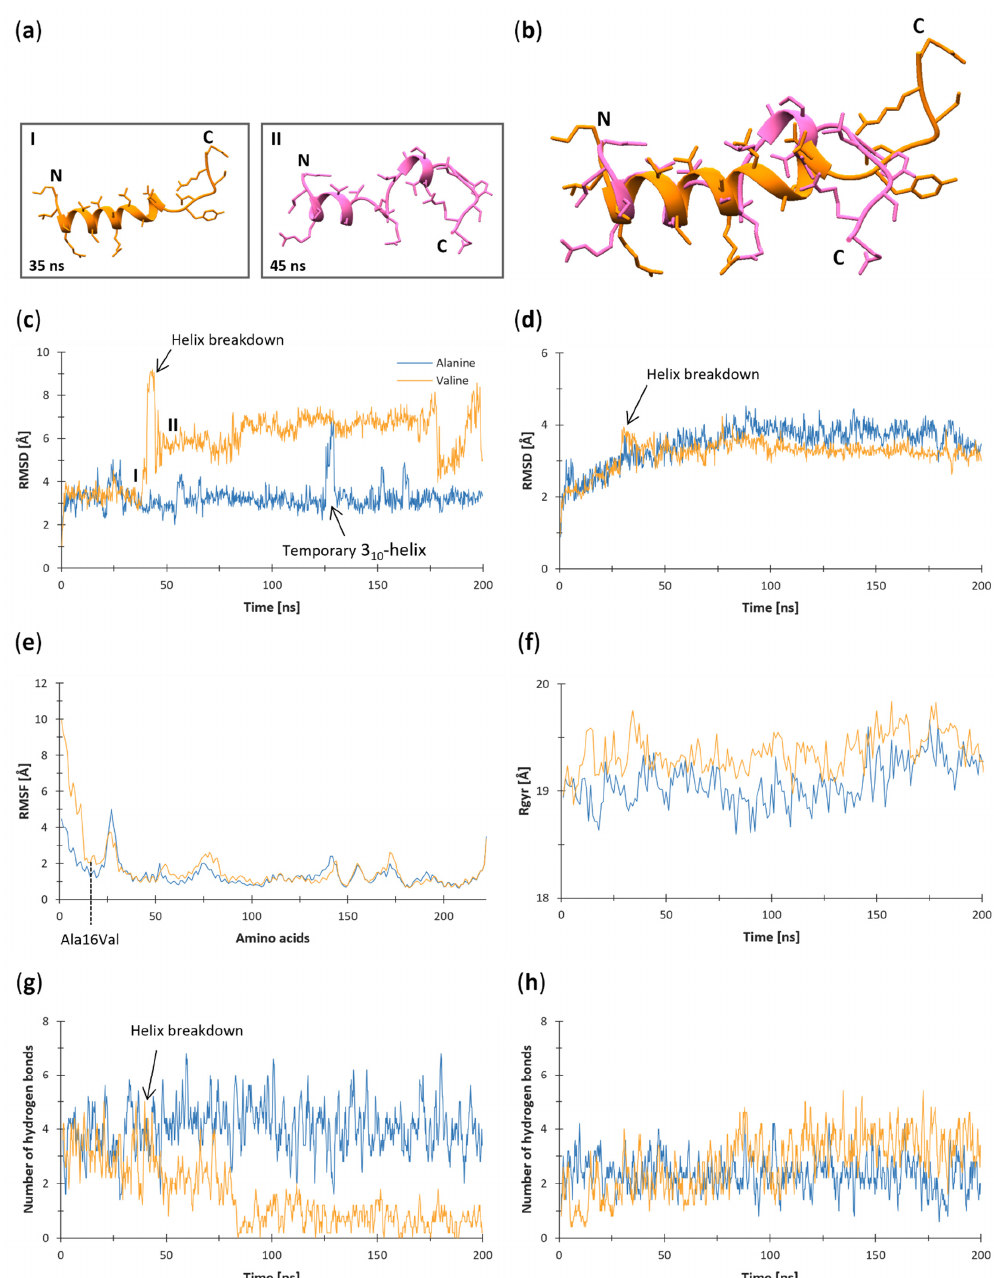
Figure 4. Cartoon representation of the Val-MTS before (35 ns) and after (45 ns) the helix breakdown and graphical representation of RMSD, RMSF, Rgyr, and hydrogen bond analysis during the 200 ns MD simulations. ( a ) Cartoons depict the MTS helix right before and after the breakdown and ( b )